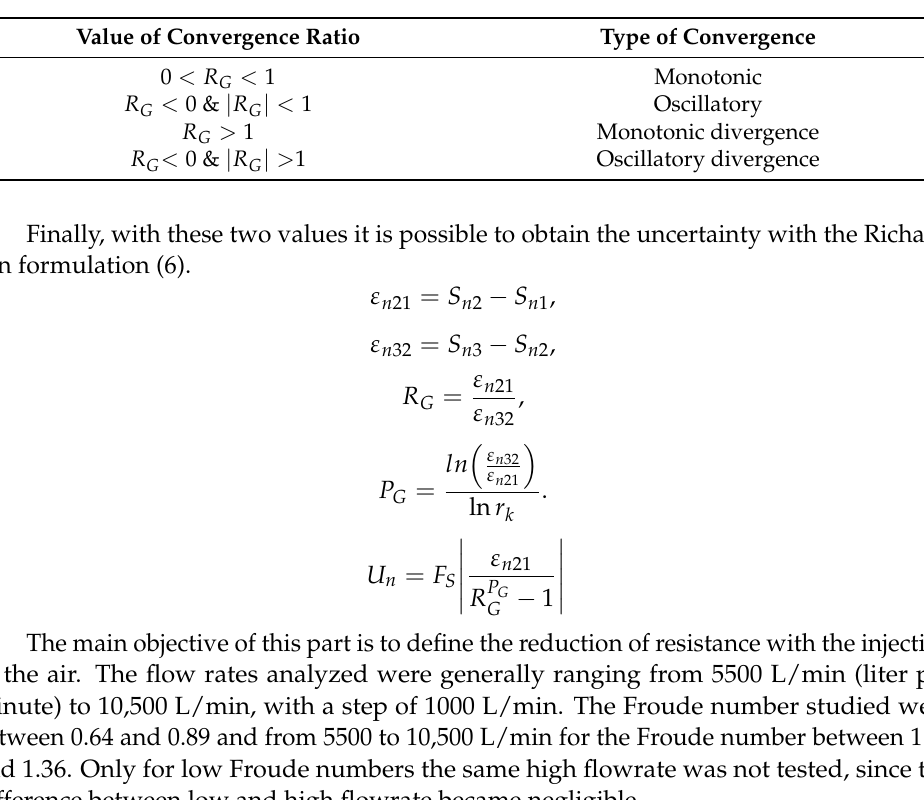
Table 3. Convergence ratio.